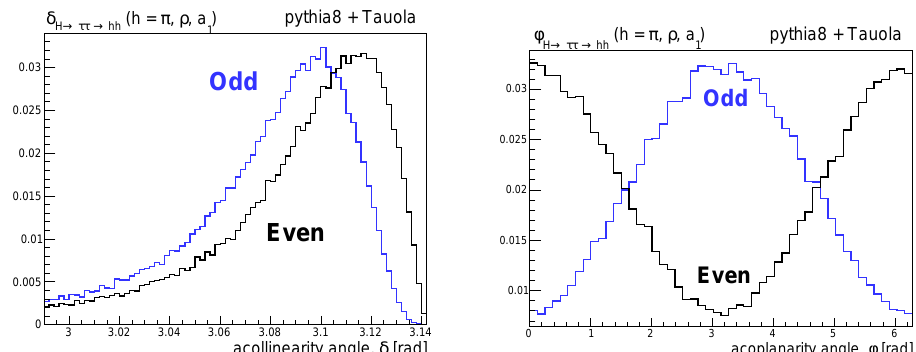
Figure 2: The distribution of δ ( Left ) and φ ( Right ) for CP even and odd